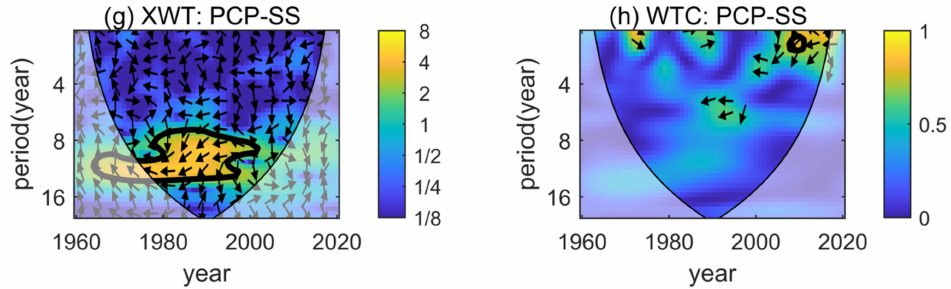
Figure 5. CWT spectrum between PCP and PDO/AO/ENSO/SS. ( a , c , e , g ) show the results of XWT; ( b , d , f , h ) show the results of